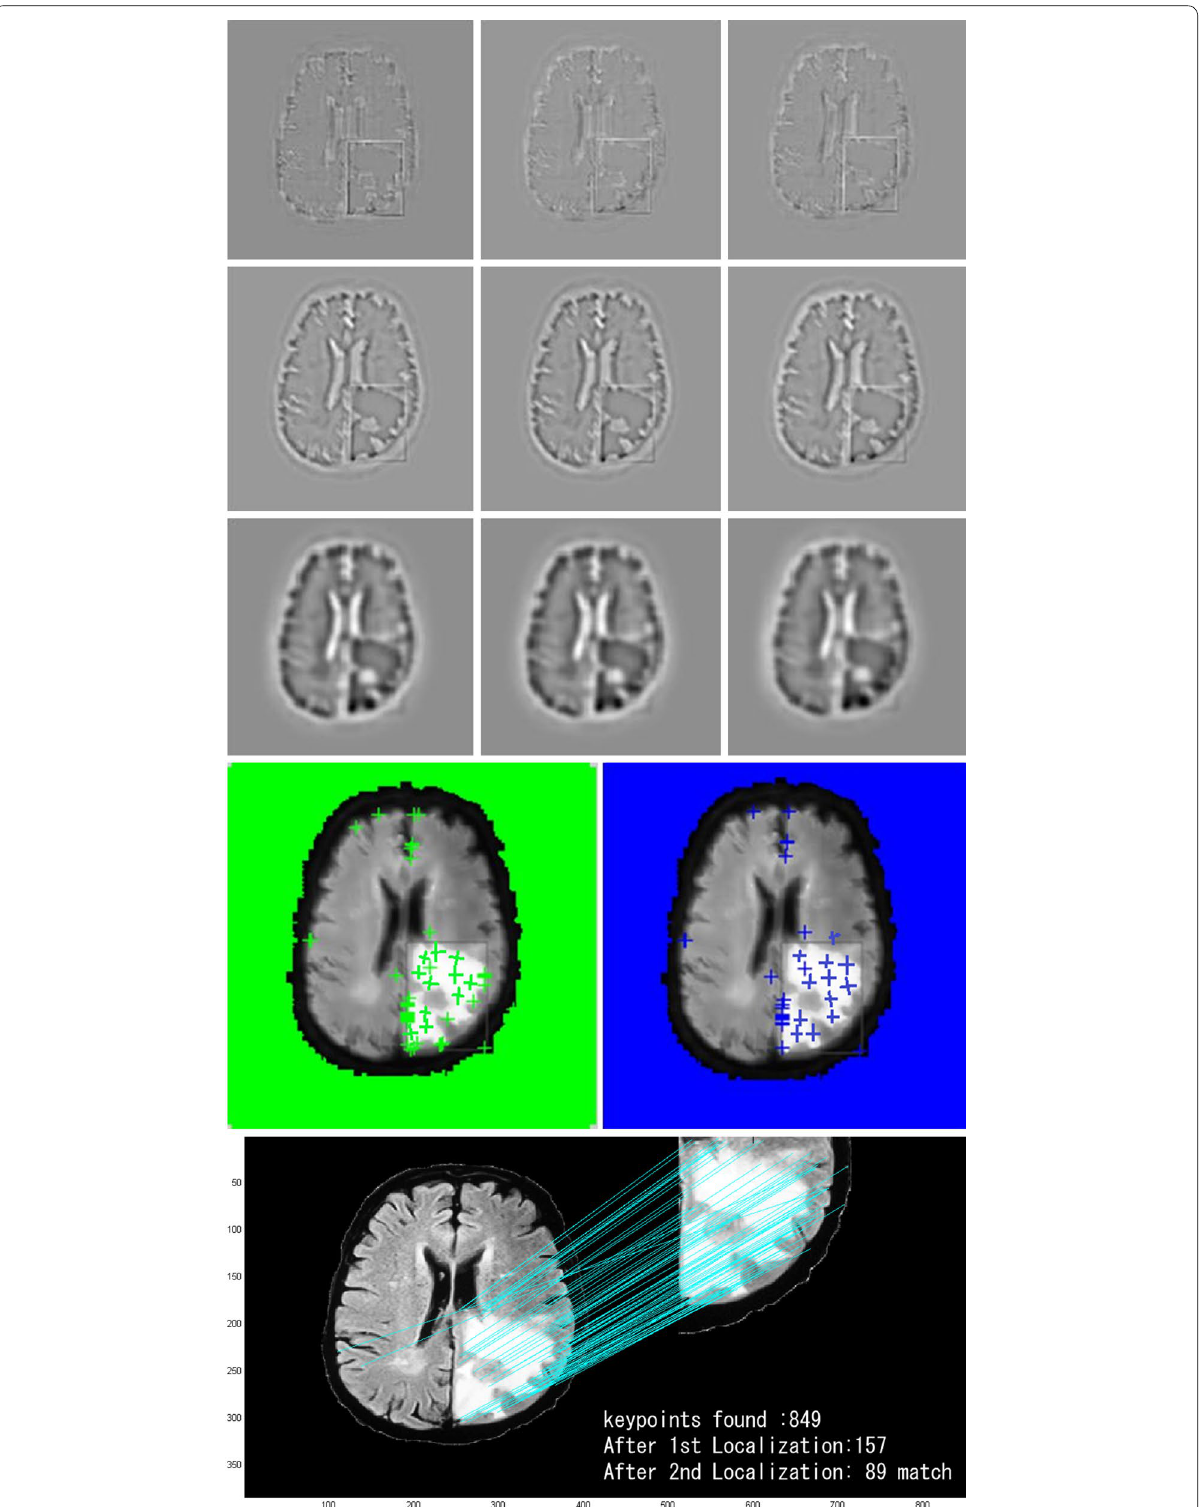
Fig. 8 Experimental result of SIFT segmentation (from top to bottom). Finding features of input MR brain tumor image, finding keypoints; the density of green signs and the blue signs on the tumor area indicate the tumor region; keypoints are localized, and then, find matching and lastly find 89 matches between the input and the output image, thus confirming the tumor area from the binary